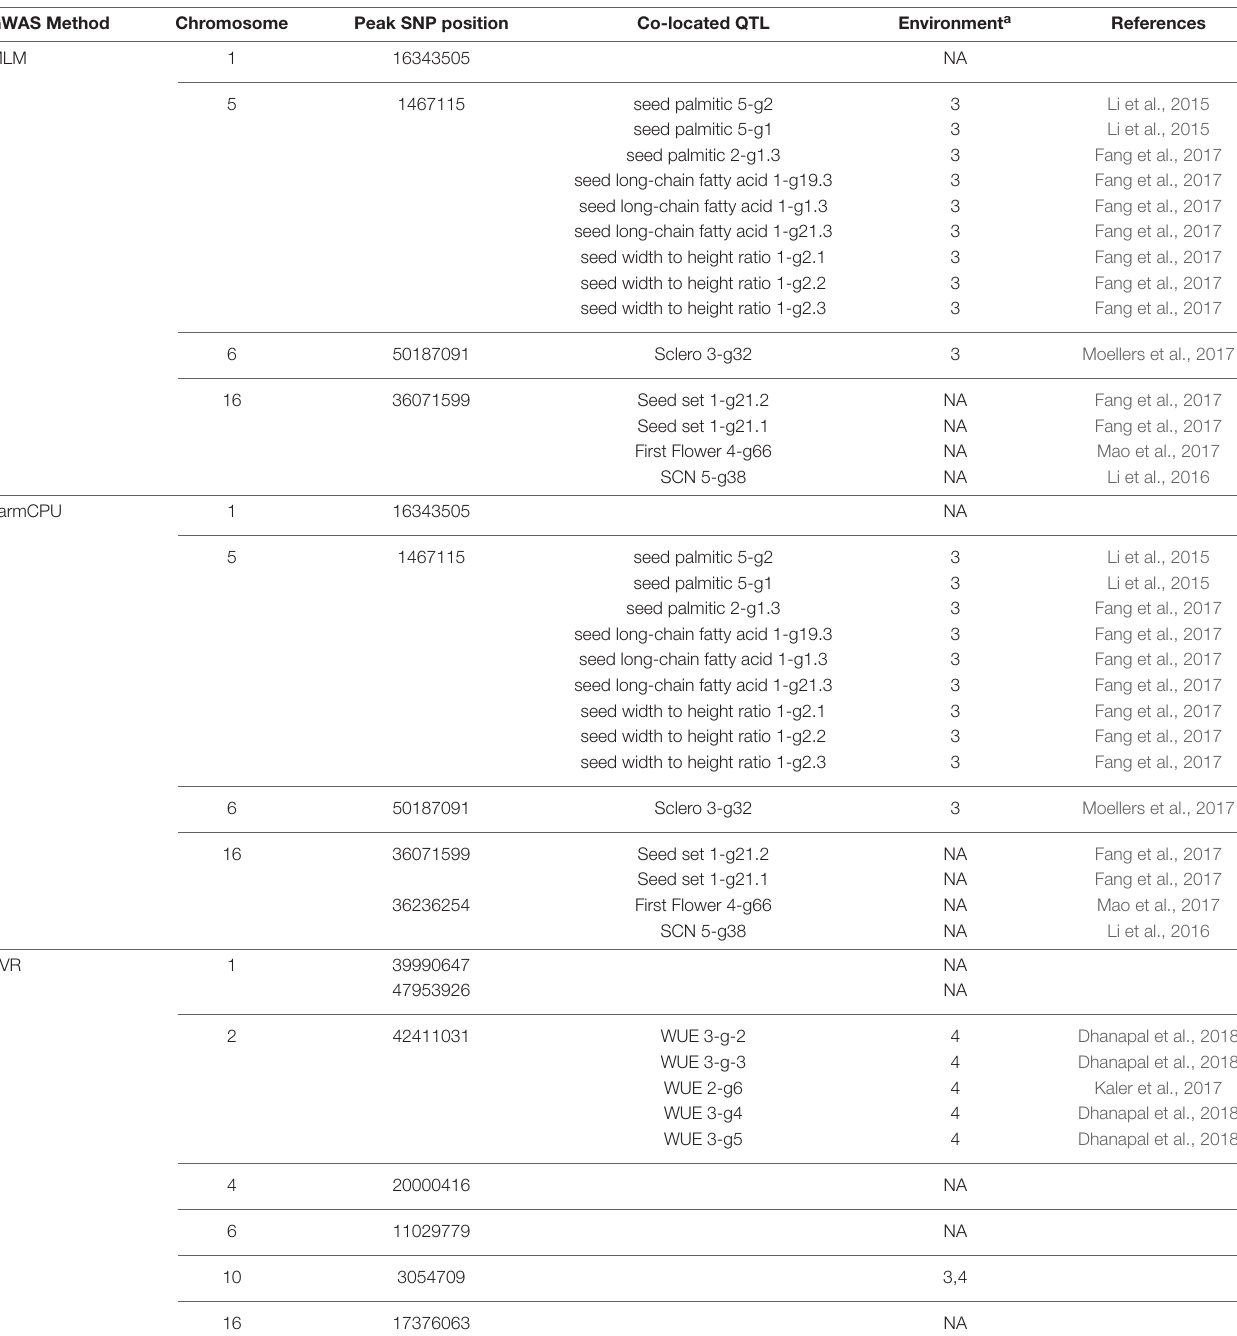
TABLE 5 | The list of detected QTLs for 820 nm using different GWAS methods in the tested soybean panel. GWAS